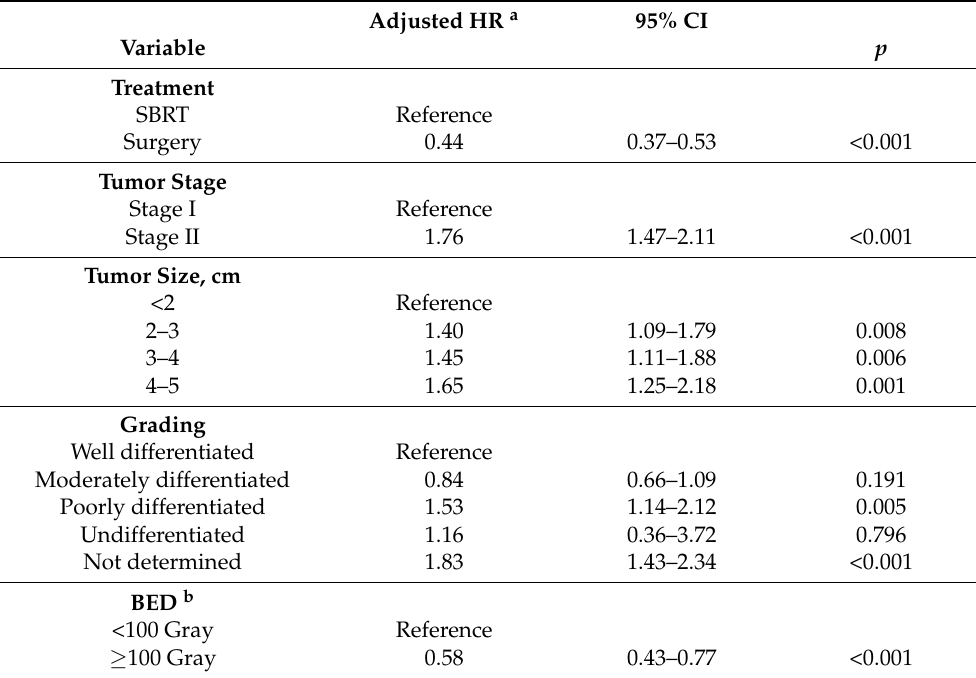
Table 2. Predictors of death (overall survival) of patients with hepatocellular carcinoma in the matched